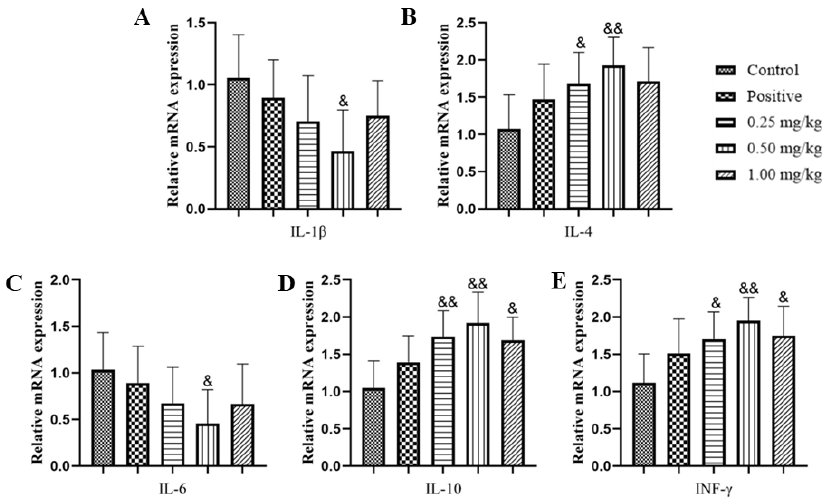
Figure 10. Expression of ( A ) IL-1 β ; ( B ) IL-4; ( C ) IL-6; ( D ) IL-10; and ( E ) INF- γ in the lungs of immu- nized mice administered with glycine nano-selenium and challenged with H9N2 avian influenza virus. Bars are represented as mean ± SD. Bars with same && or & are statistically the same (n = 5, p < 0.05 or p < 0.01). Control, received no immunization + 0.5 mL normal saline; positive, received H9N2 AIV vaccine + 0.5 mL 0.9% normal saline; 0.25 mg/kg group, received H9N2 AIV vaccine + 0.5 mL 0.25 mg/kg selenium solution; 0.5 mg/kg group, received H9N2 AIV vaccine + 0.5 mL 0.5 mg/kg selenium solution; 1 mg/kg group, received H9N2 AIV vaccine + 0.5 mL 1 mg/kg selenium solution.